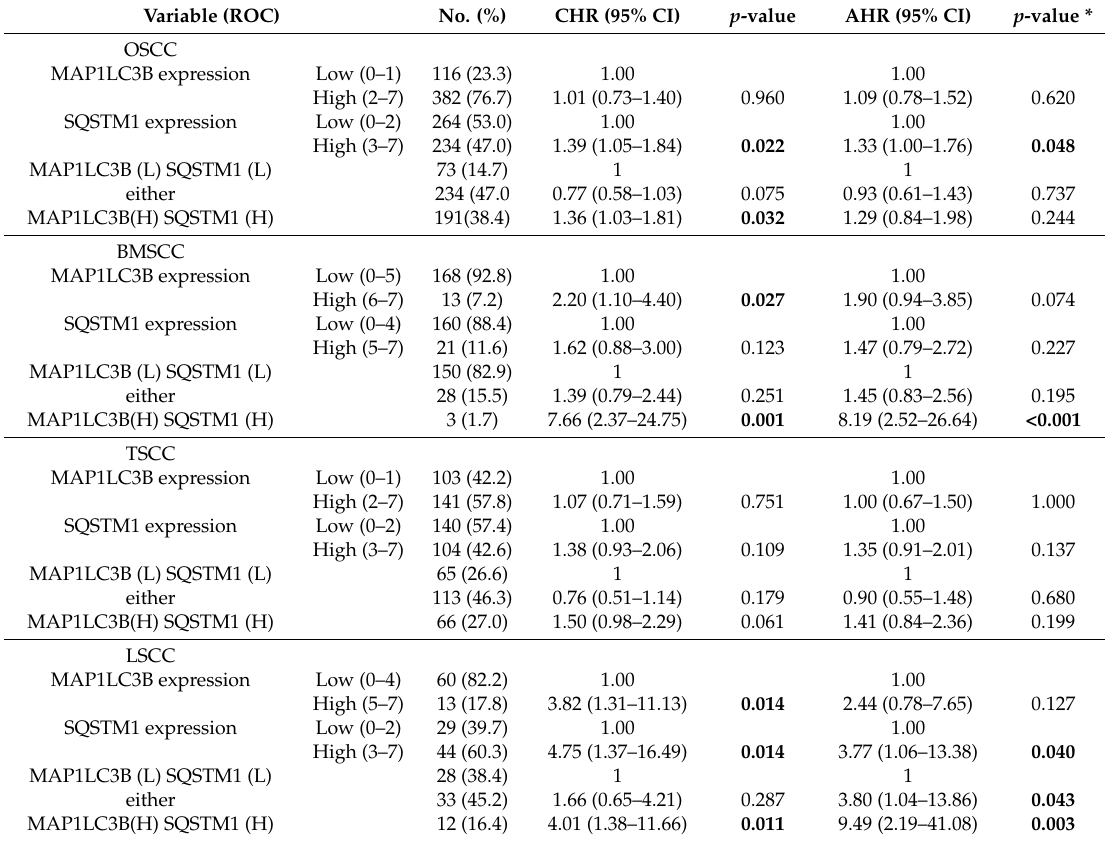
Table 6. The expression levels of MAP1LC3B and SQSTM1 in disease-free survival of oral SCC patients. Variable (ROC) No. (%) CHR (95% CI) p -value AHR (95% CI) OSCC MAP1LC3B expression